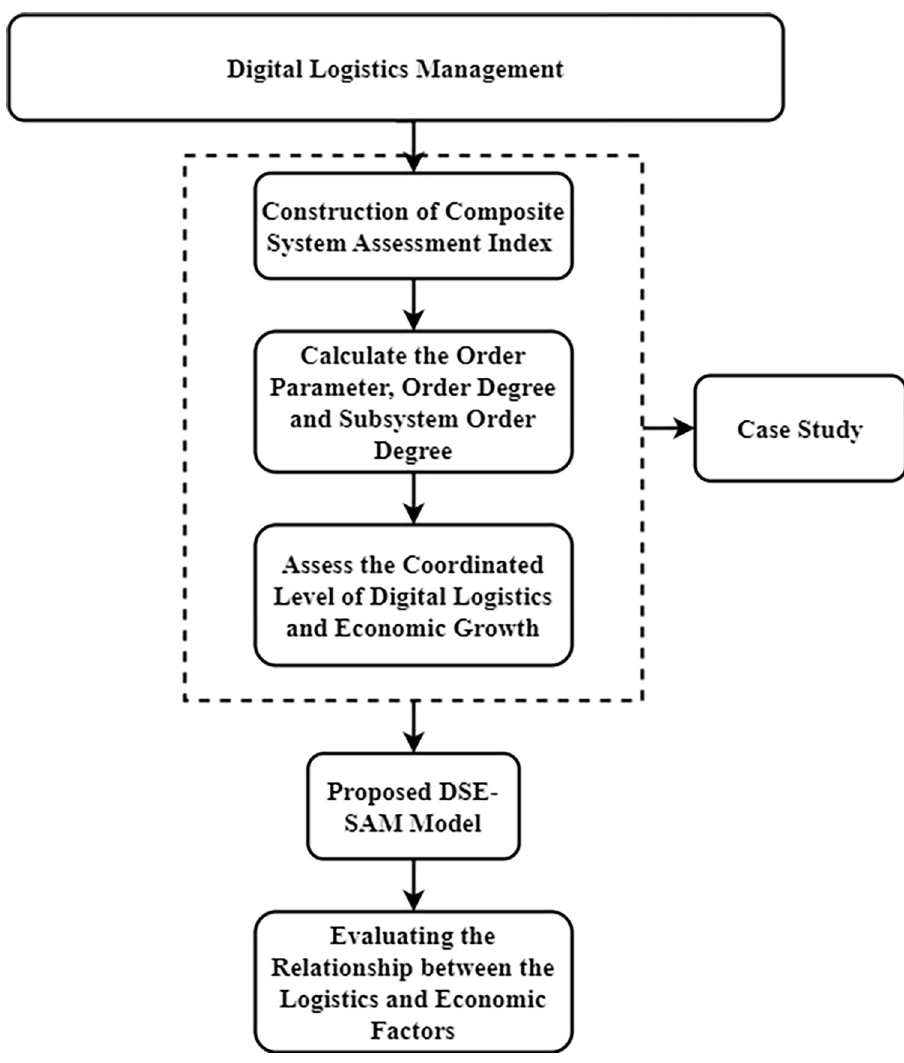
Fig 1. Proposed DSE-SAM